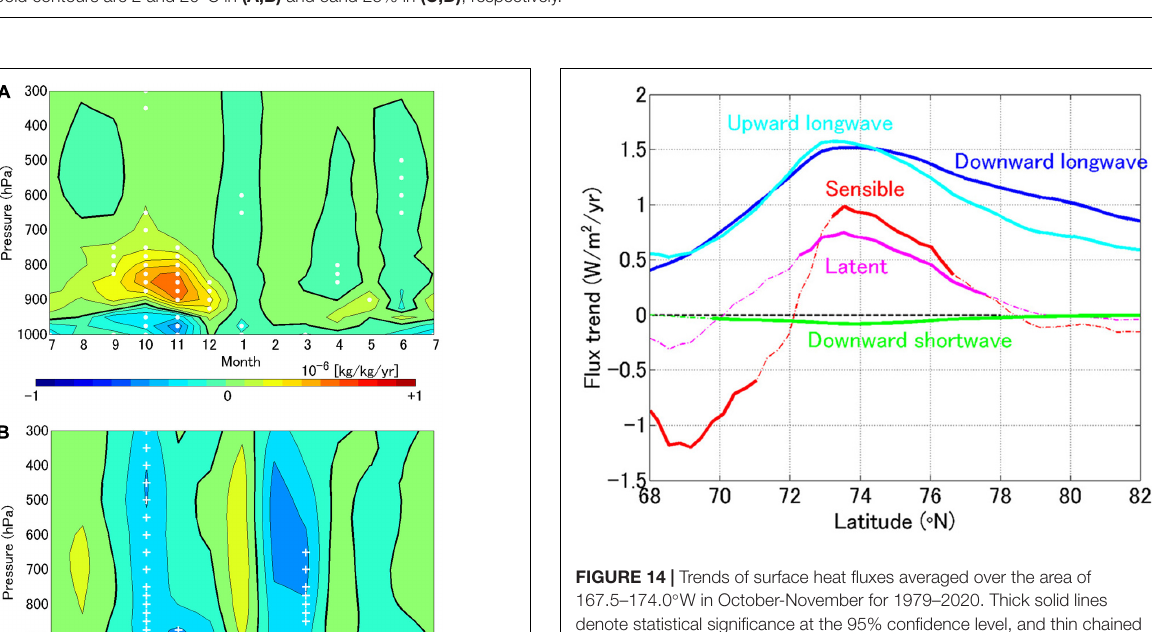
FIGURE 12 | Latitude-time sections of (A,B) ST and (C,D) sea ice concentration trends for 1979–2020 in (A,C) the Chukchi Sea and (B,D) the Bering Sea. White dots denote statistical significance at the 95% confidence level. Contours show climatologies of (A,B) ST and (C,D) sea ice concentration. The intervals indicated by thin and bold contours are 2 and 20 ◦ C in (A,B) and 5and 25% in (C,D) , respectively.